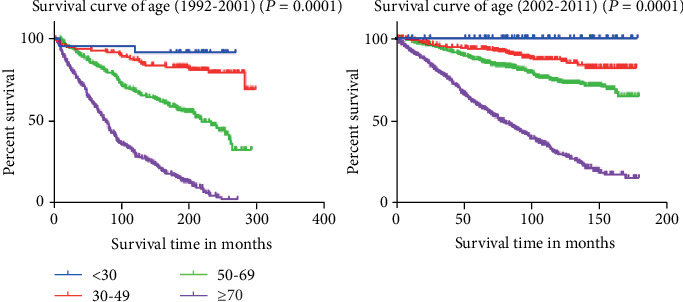
Kaplan-Meier estimate of the overall survival of specific age groups in the 1992-2001 and 2002-2011 patient cohorts.